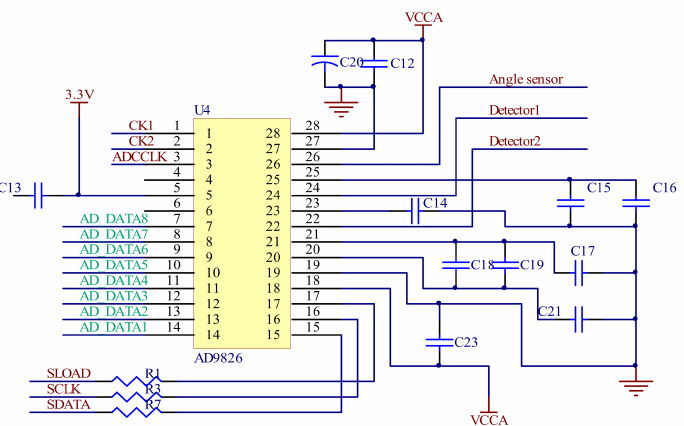
Figure 11. ADC circuit of the signal acquisition